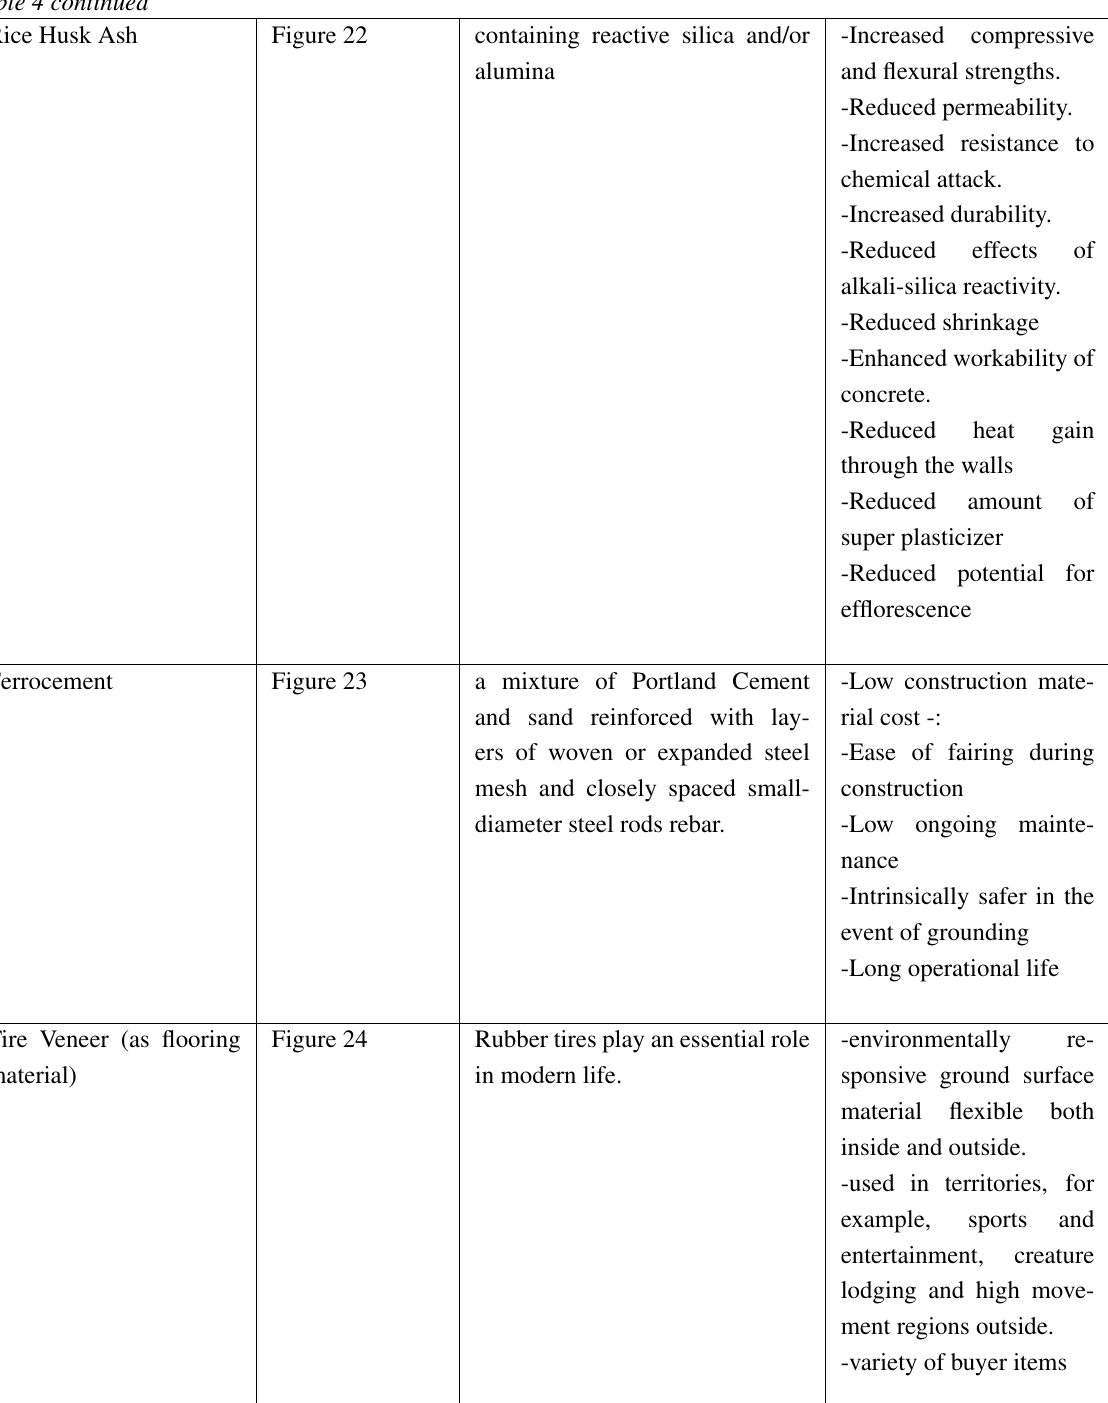
Figure 23 a mixture of Portland Cement and sand reinforced with lay- ers of woven or expanded steel mesh and closely spaced small- diameter steel rods rebar.